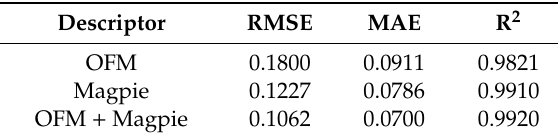
Table 3. RMSE (eV / atom), MAE (eV / atom) and R 2 values of cross-validation results in three cases of Table 3. RMSE (eV/atom), MAE (eV/atom) and R 2 values of cross-validation results in three cases of CNN.